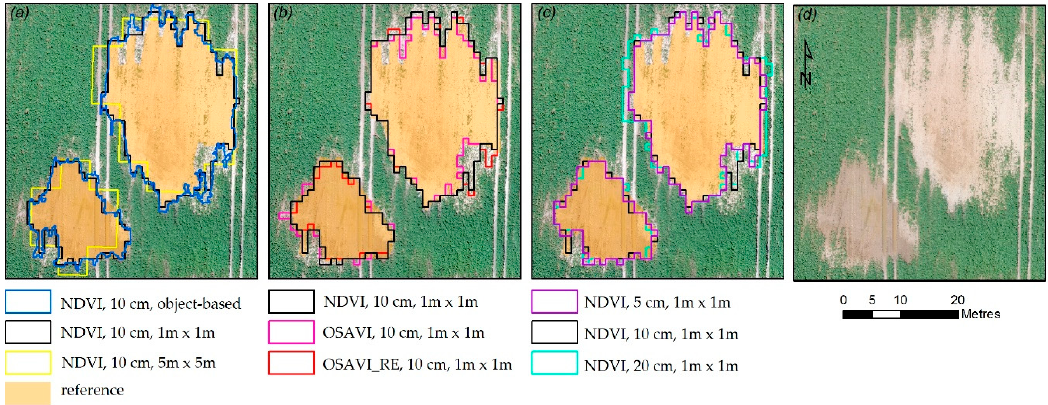
Figure 10. Small fragment of true color orthomosaic with reference mask and detected areas of damaged rapeseed without the influence of roads: ( a ) in three different approaches, ( b ) with three different indices, ( c ) with three different resolutions ( d ) true color orthomosaic.